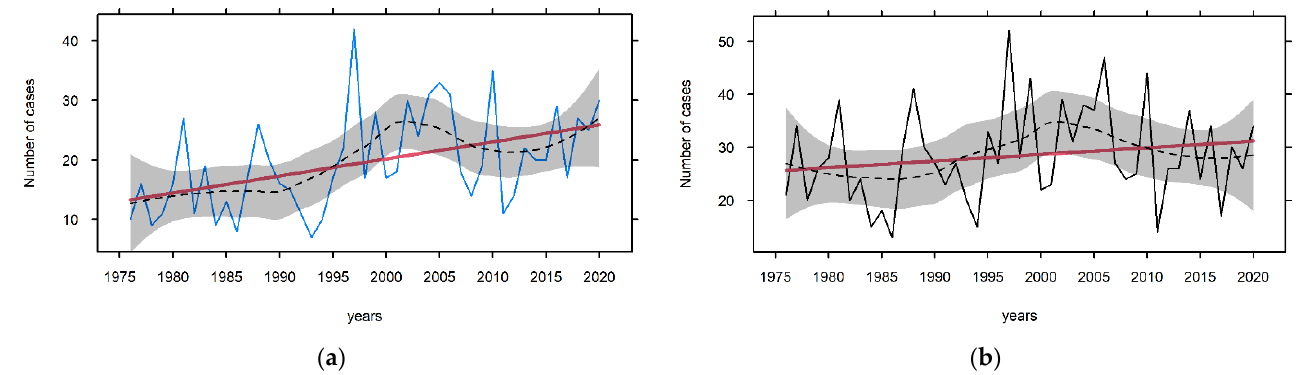
Figure 3. Long-term variability in the frequency of ( a ) SWPp and ( b ) SWP in Crimea for 1976–2020. The red line depicts a linear trend and the black dotted line and the grey-filled area are local polynomial smoothing and corresponding 95%-confidence region, respectively.